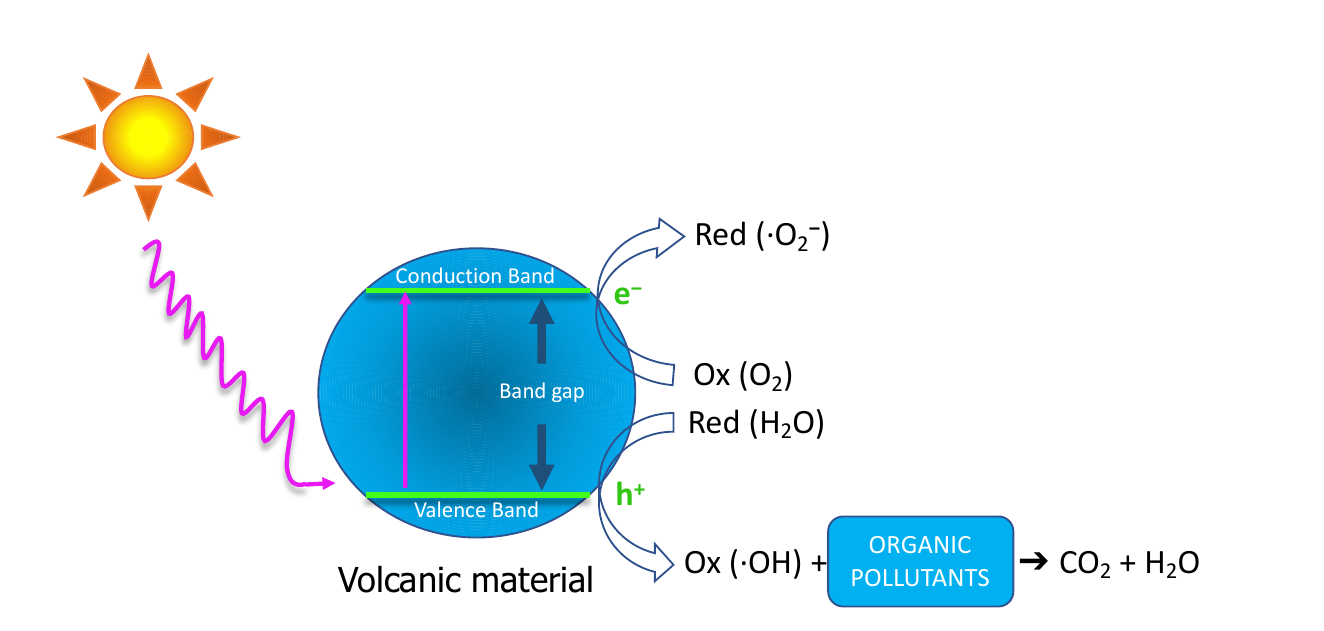
Figure 1. Mechanism schema of photocatalytic degradation of organic pollutants into CO 2 and H 2 O in photocatalytic active